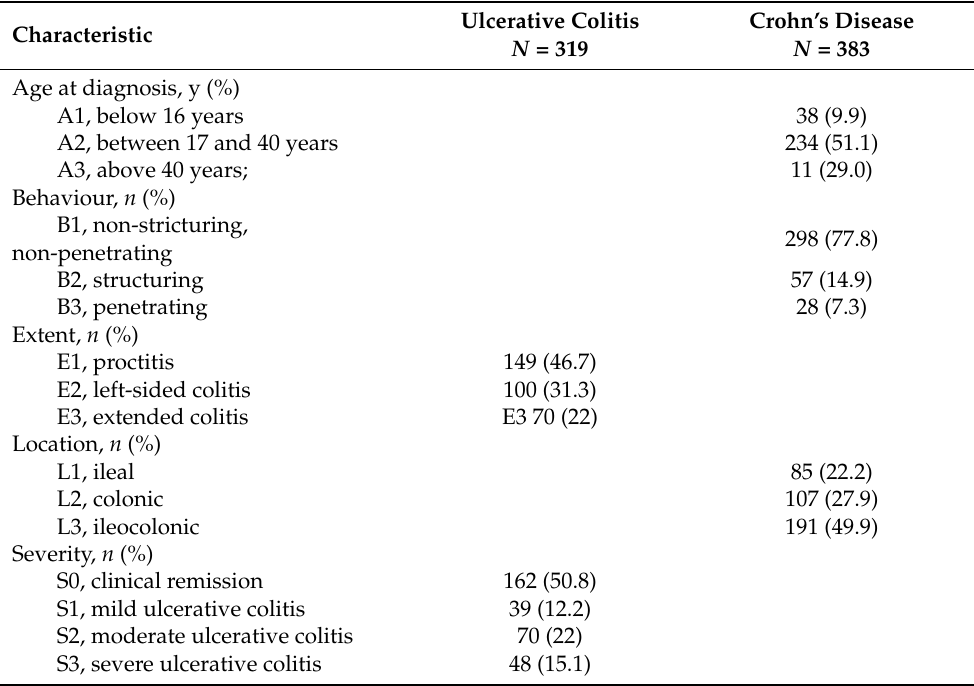
Table 1. Characteristics of ulcerative colitis and Crohn’s disease patients according to the Montreal classification.